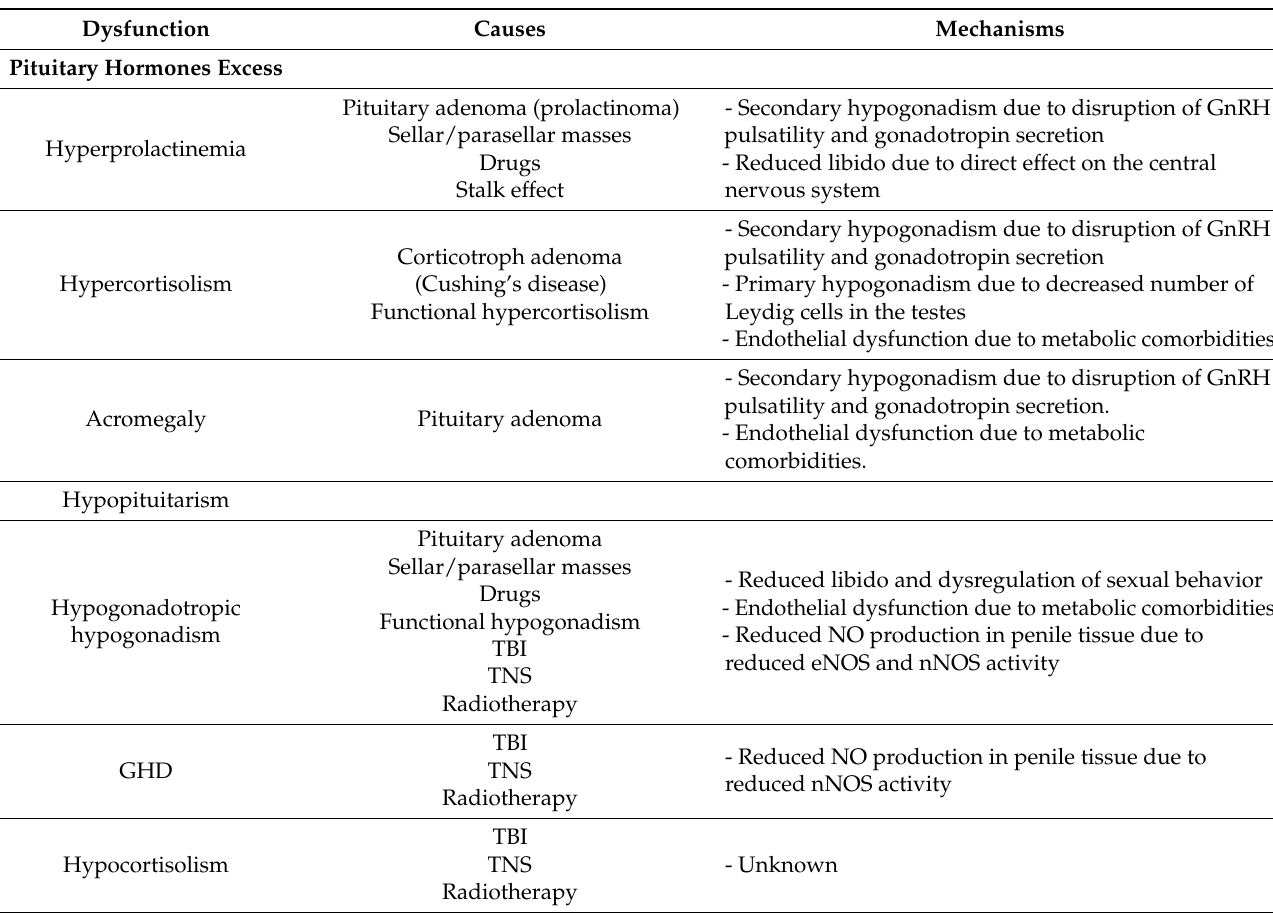
Table 1. Hypothalamic–pituitary diseases associated with erectile dysfunction and proposed